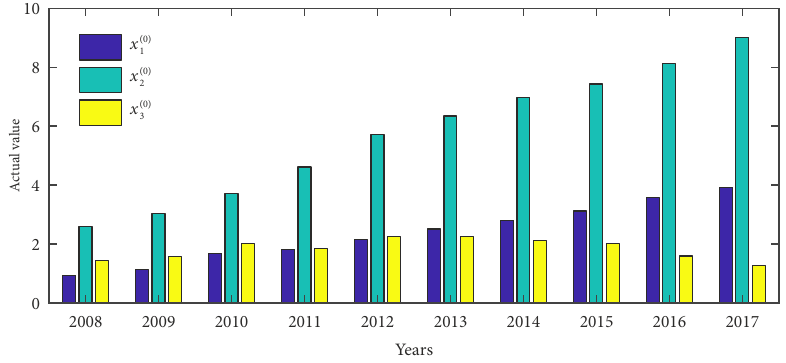
Figure 3. The description about modeling